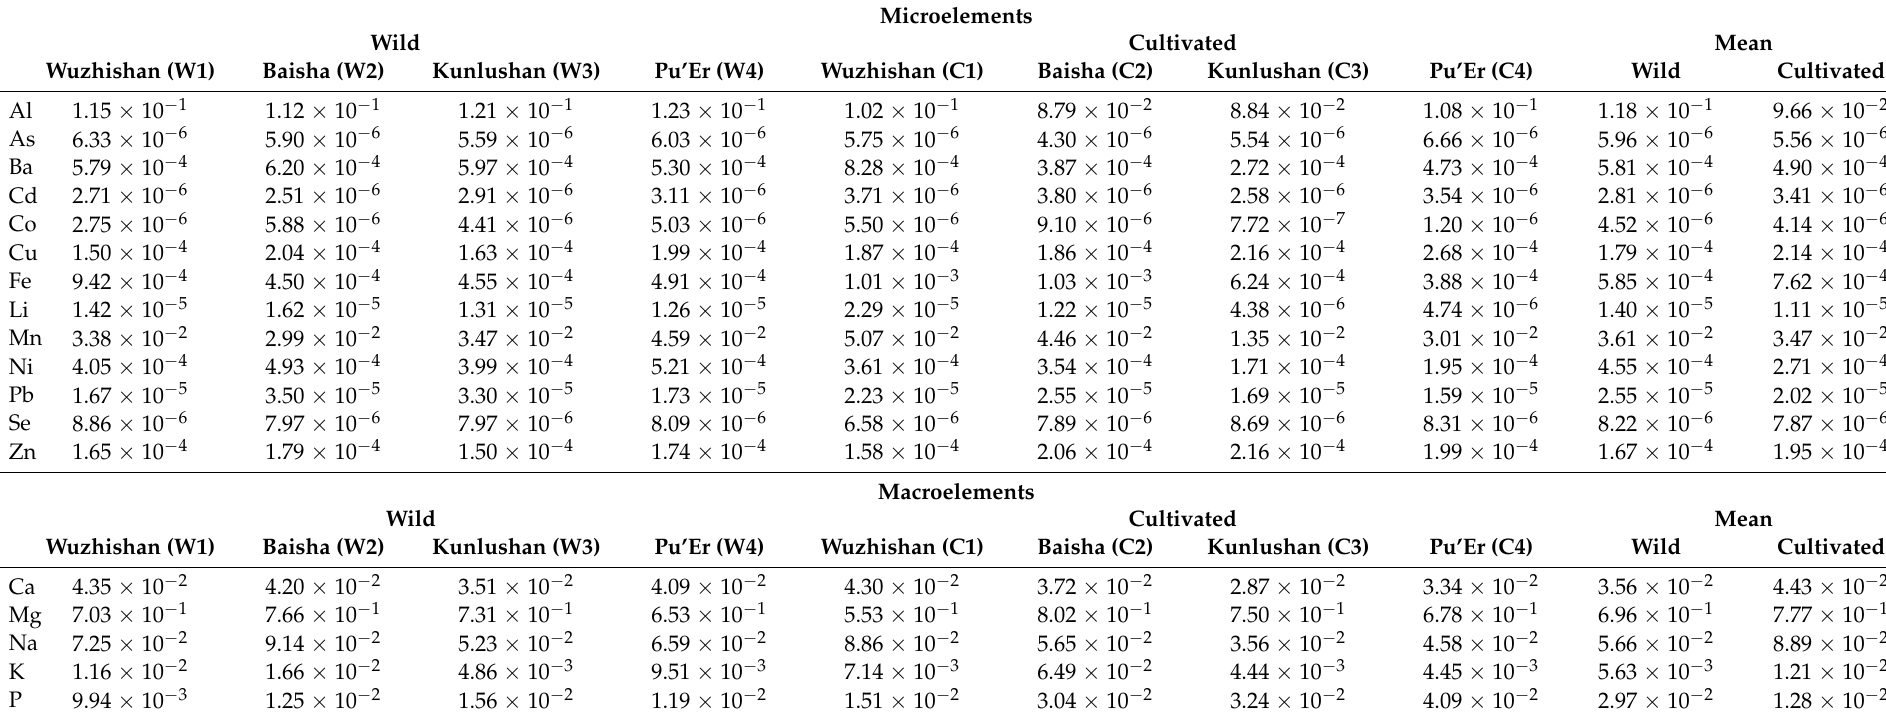
Table 5. Estimated daily intakes (EDI) (mg · kg − 1 bw · day − 1 ) of micro- and macroelements for adults due to the consumption of